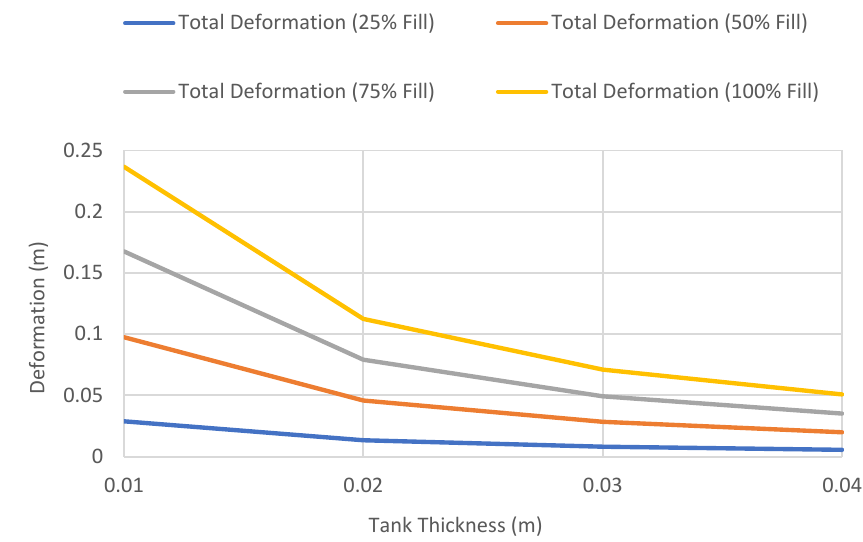
Figure 3. Variation of maximum total deformation of different fill levels versus tank thickness.